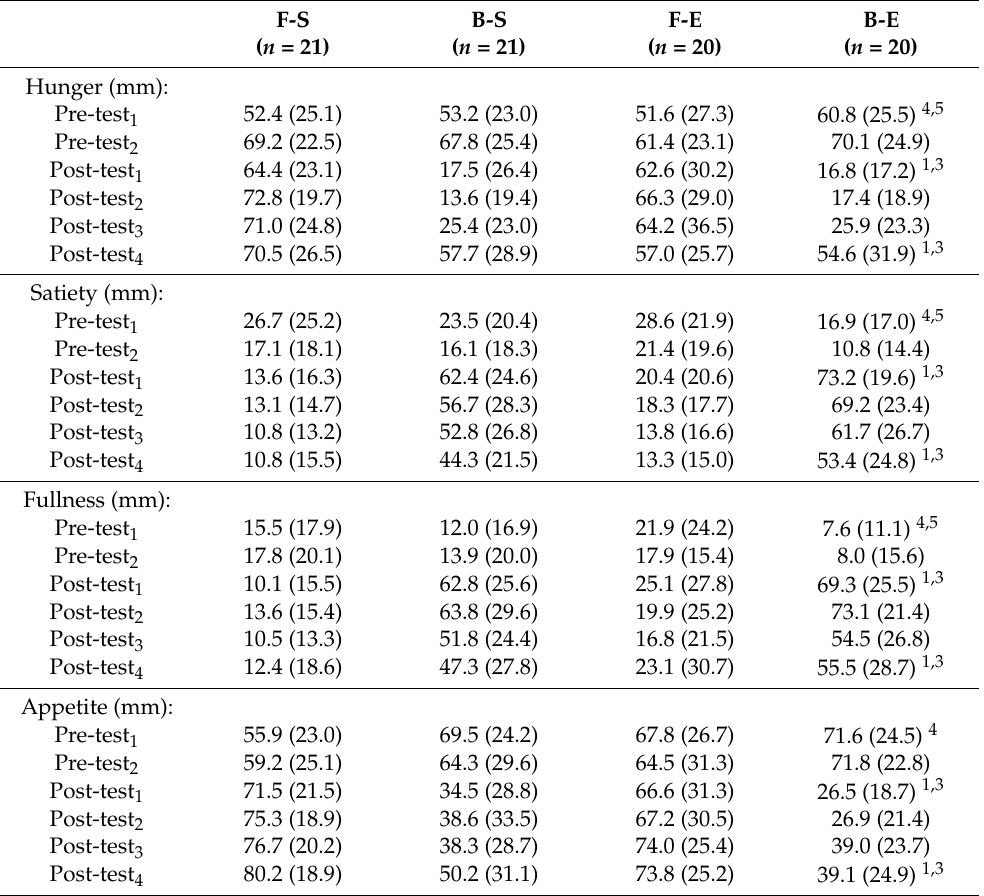
Table A1. Subjective ratings of hunger, satiety, fullness and appetite across the morning based on 100 mm 4 visual analogue scores.